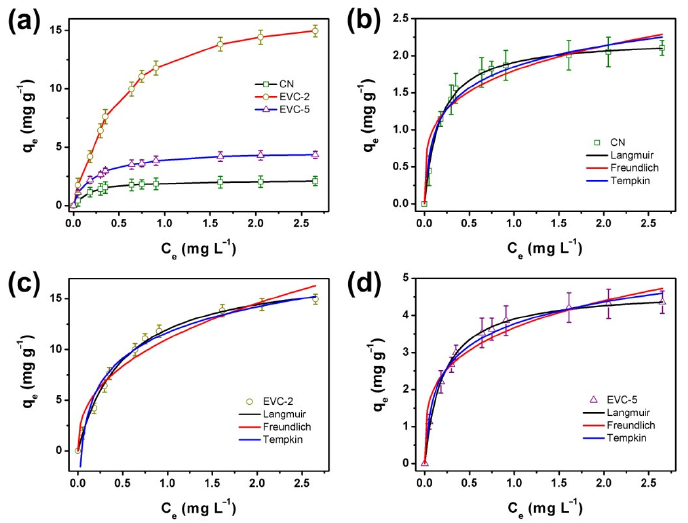
Figure 7. ( a ) Adsorption isotherms of MB (5 mg L −1 ) on CN, EVC-2, and EVC-5: Langmuir, Freun- dlich, and Tempkin isotherm model for the adsorption of MB on ( b ) CN, ( c ) EVC-2, and ( d )